Question: State the chart type depicted above.
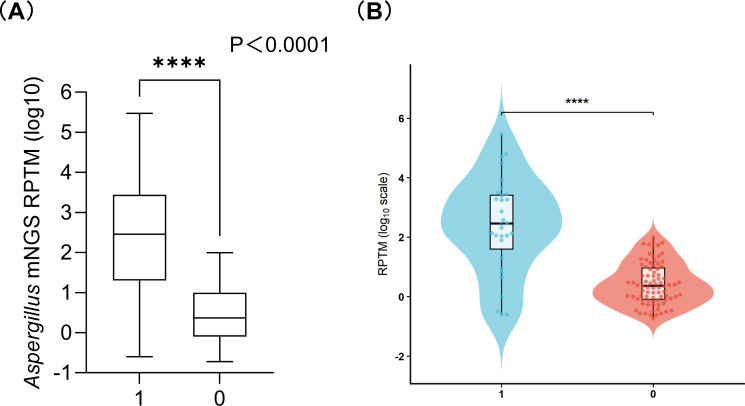
Answer: box